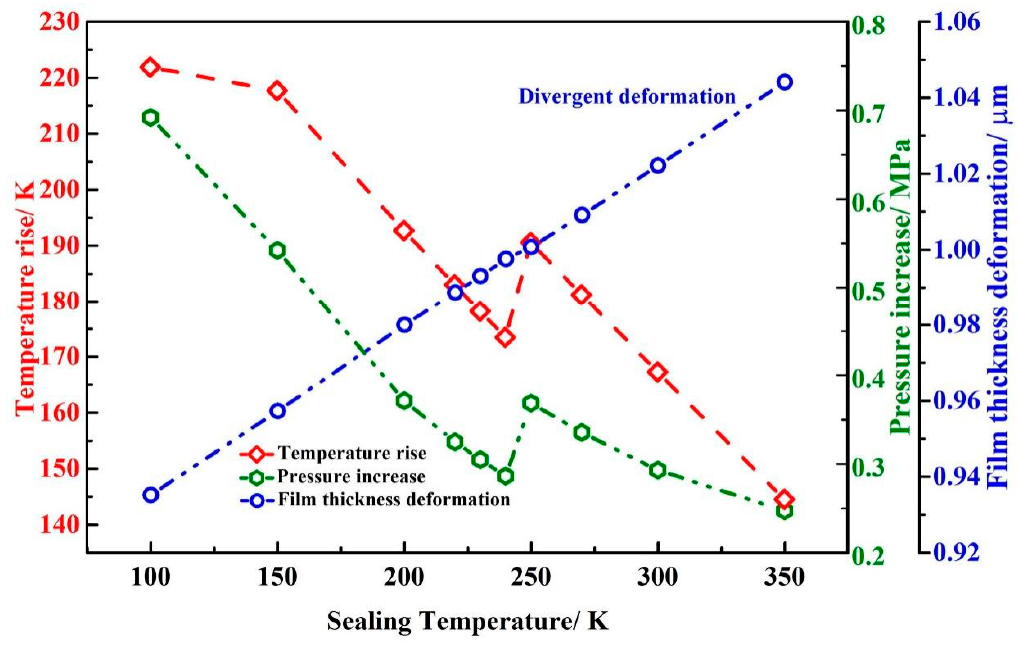
Figure 8. Variations of the pressure increase, temperature rise, and film thickness deformation with respect to the sealing temperature. ( P in = 5.0 MPa, P out = 0.1 MPa, T out = 350 K, n = 50,000 rpm, h 0 = 3 μ m).